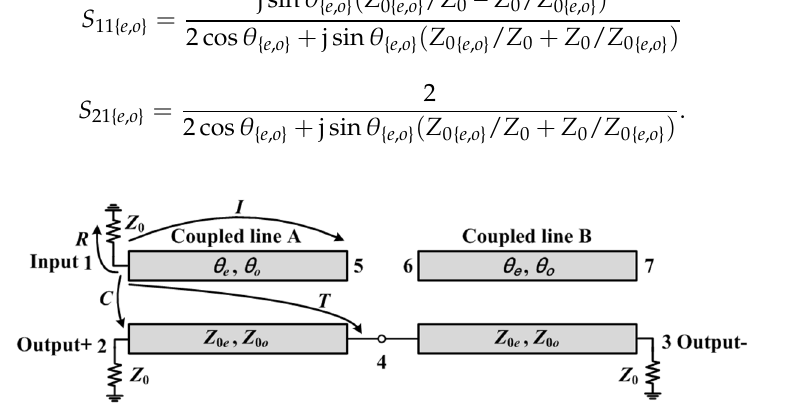
Figure 2. Equivalent circuit of the proposed balun for signal flow analysis.